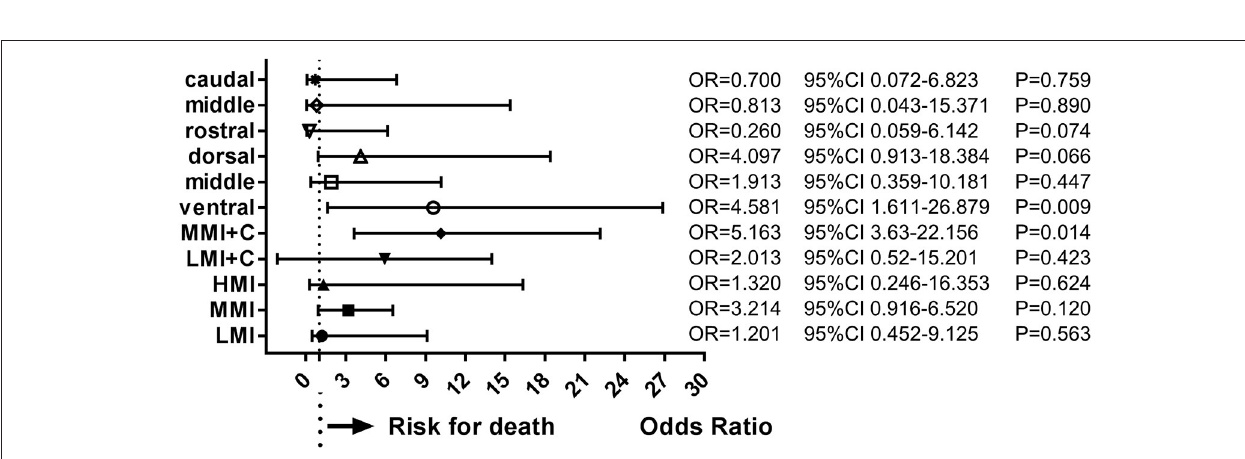
FIGURE 5 | Risk factors of stroke mechanisms for death. AAE was a risk factor for long-term death. ABO, atheromatous branch occlusion; AAE, artery-to-artery embolism; CE, cardiogenic embolism; SVD, small vessel disease; DIS, dissection; UN, undetermined.